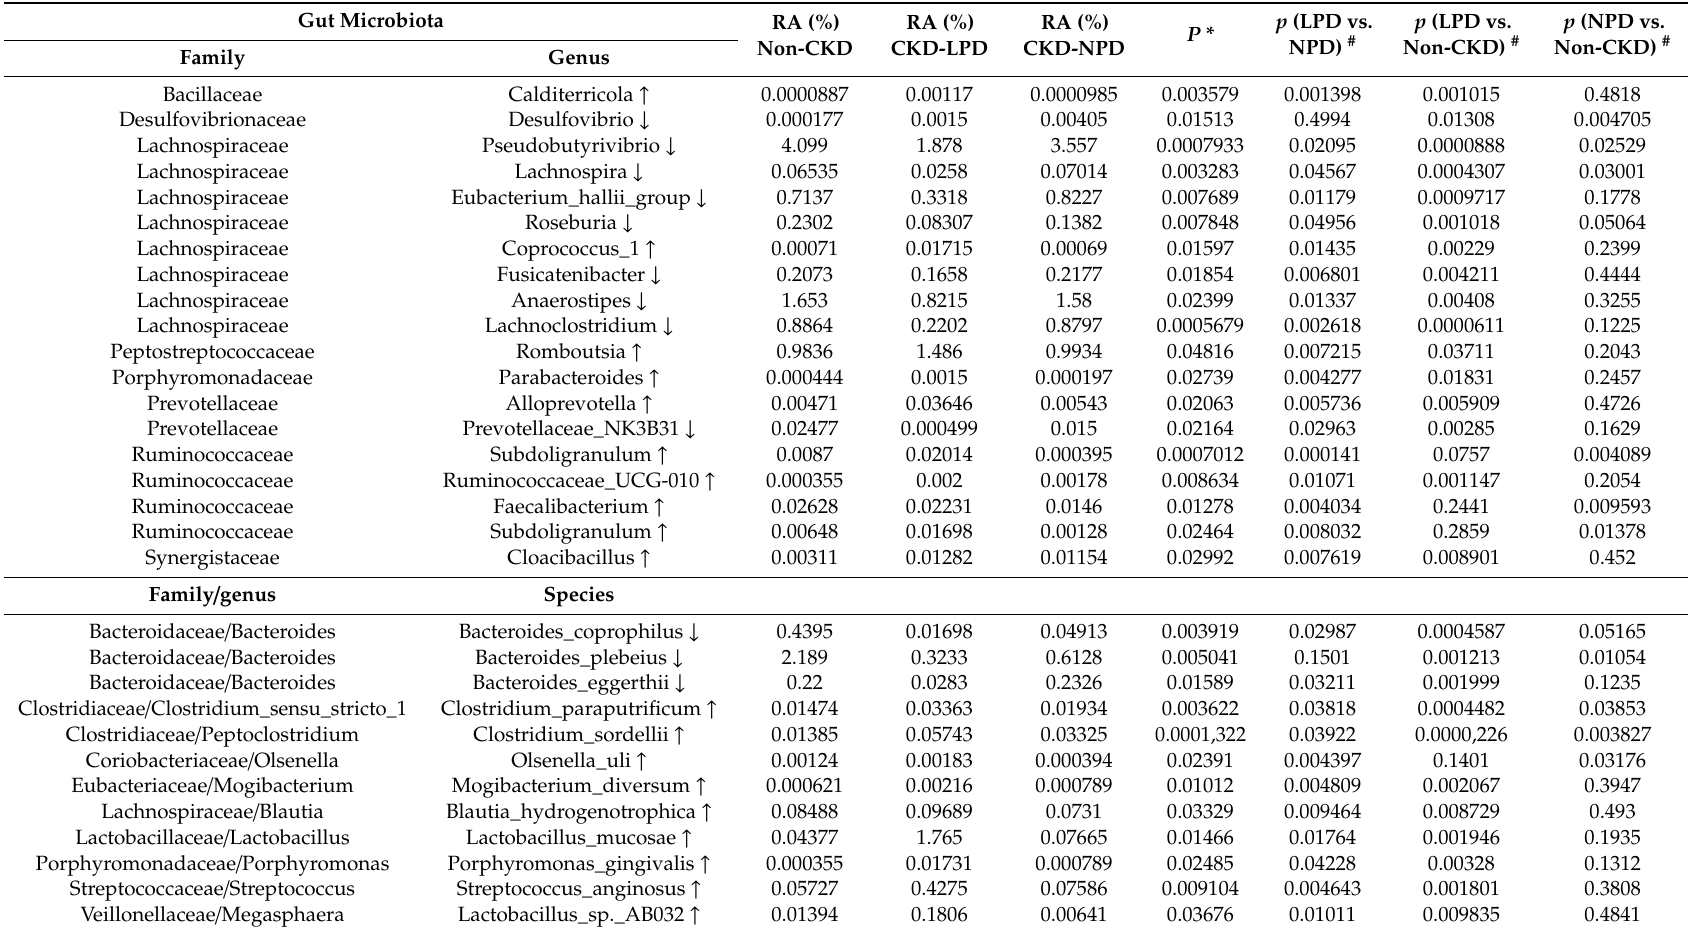
Table 2. Change of gut microbiota (at genus and species-level) associated with di ff erent dietary